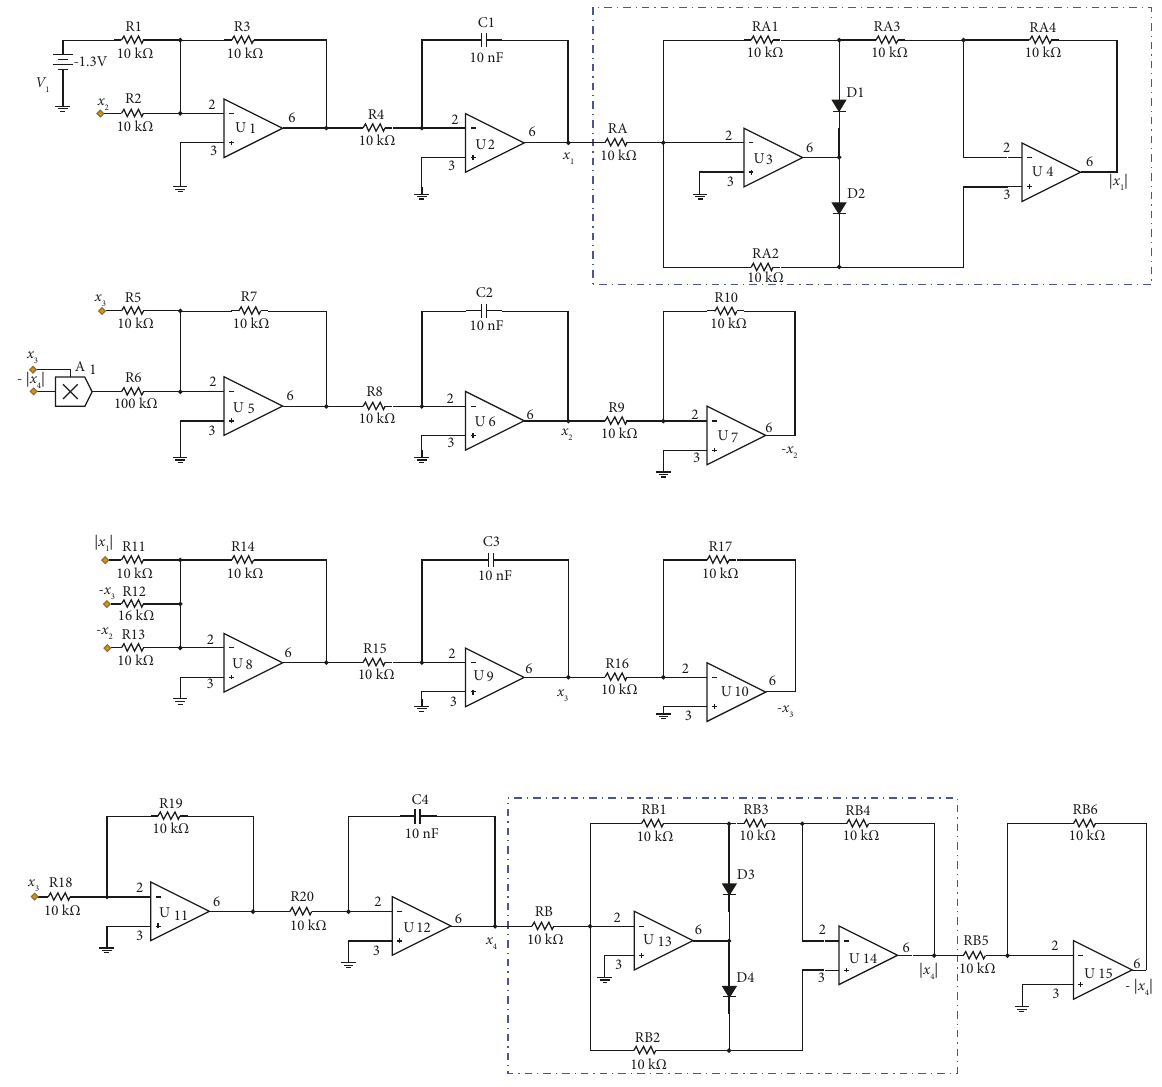
Figure 19: Schematic diagram of the system analog circuit implementation.